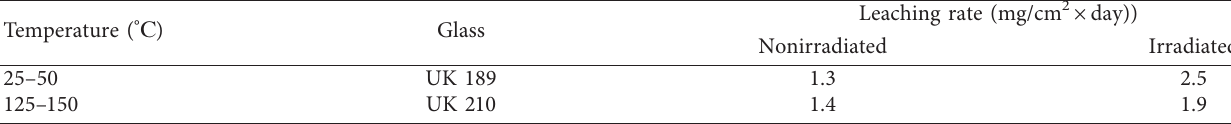
Table 8: Effect of β -irradiation equivalent to 3 × 10 9 Gy on leaching rates of borosilicate glasses